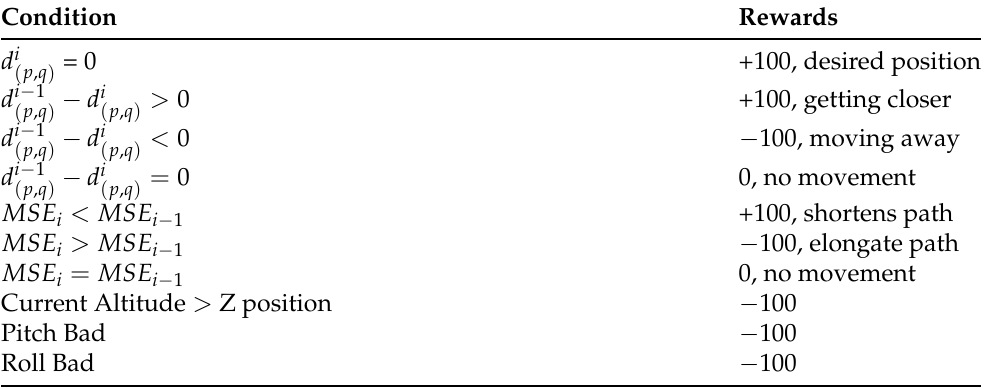
Table 3. Rewards